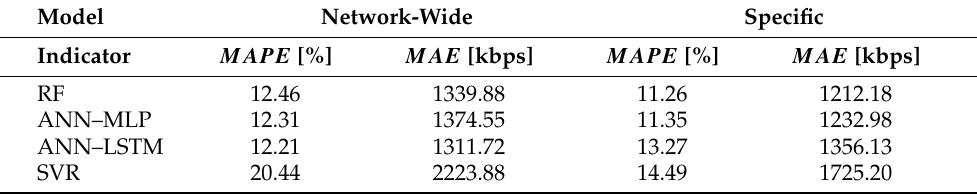
Table 5. Performance of network-wide and specific models for high-traffic cells in case 12-3.